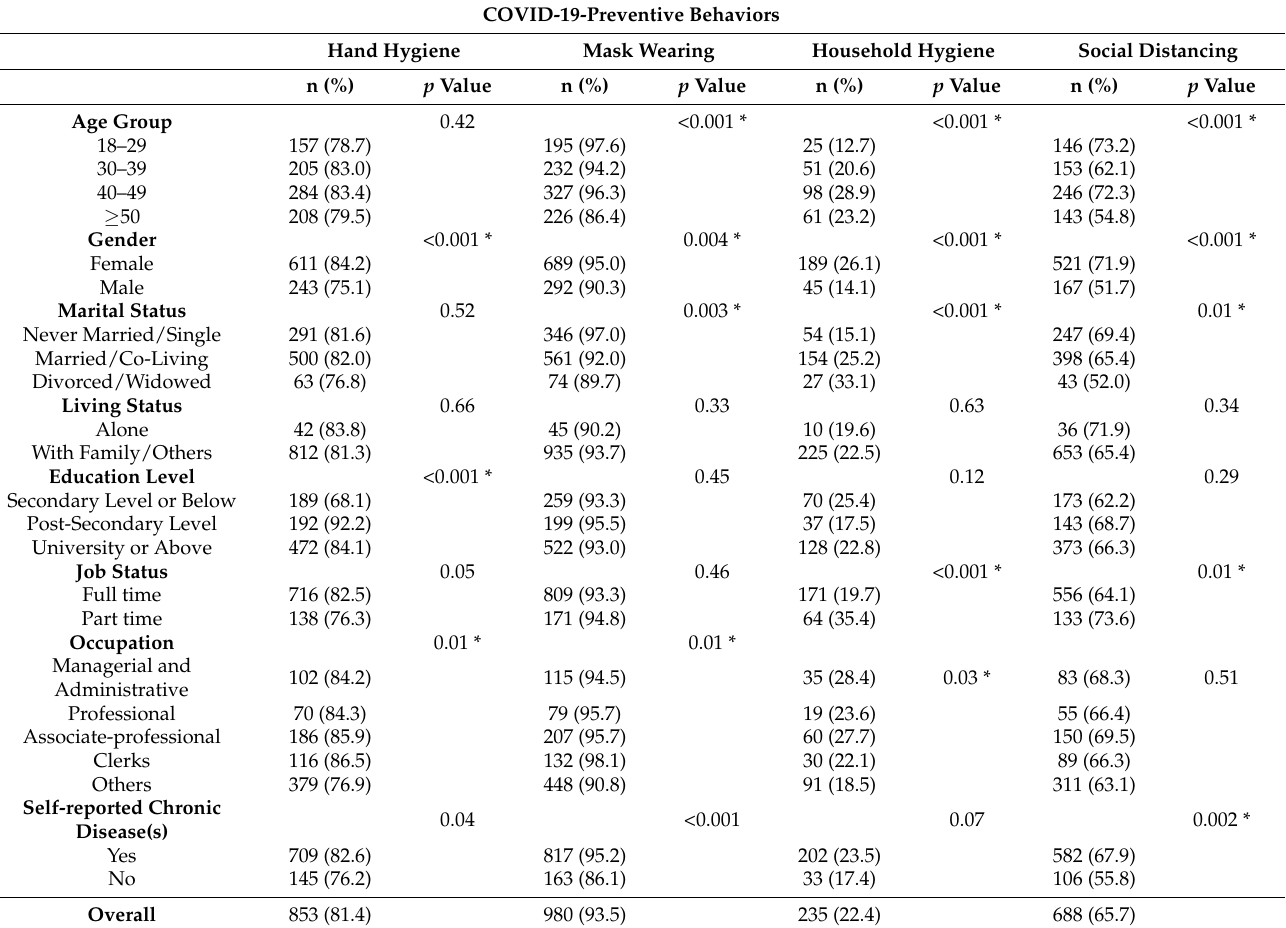
Table 2. Compliance of COVID-19-preventive behaviors (weighted with